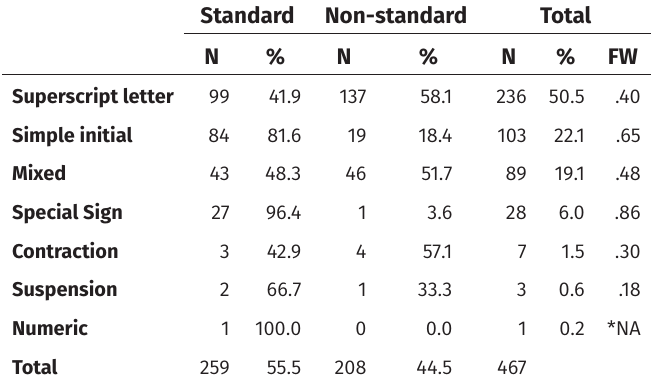
Table 4: Use of standard and non-standard variants depending on the type of